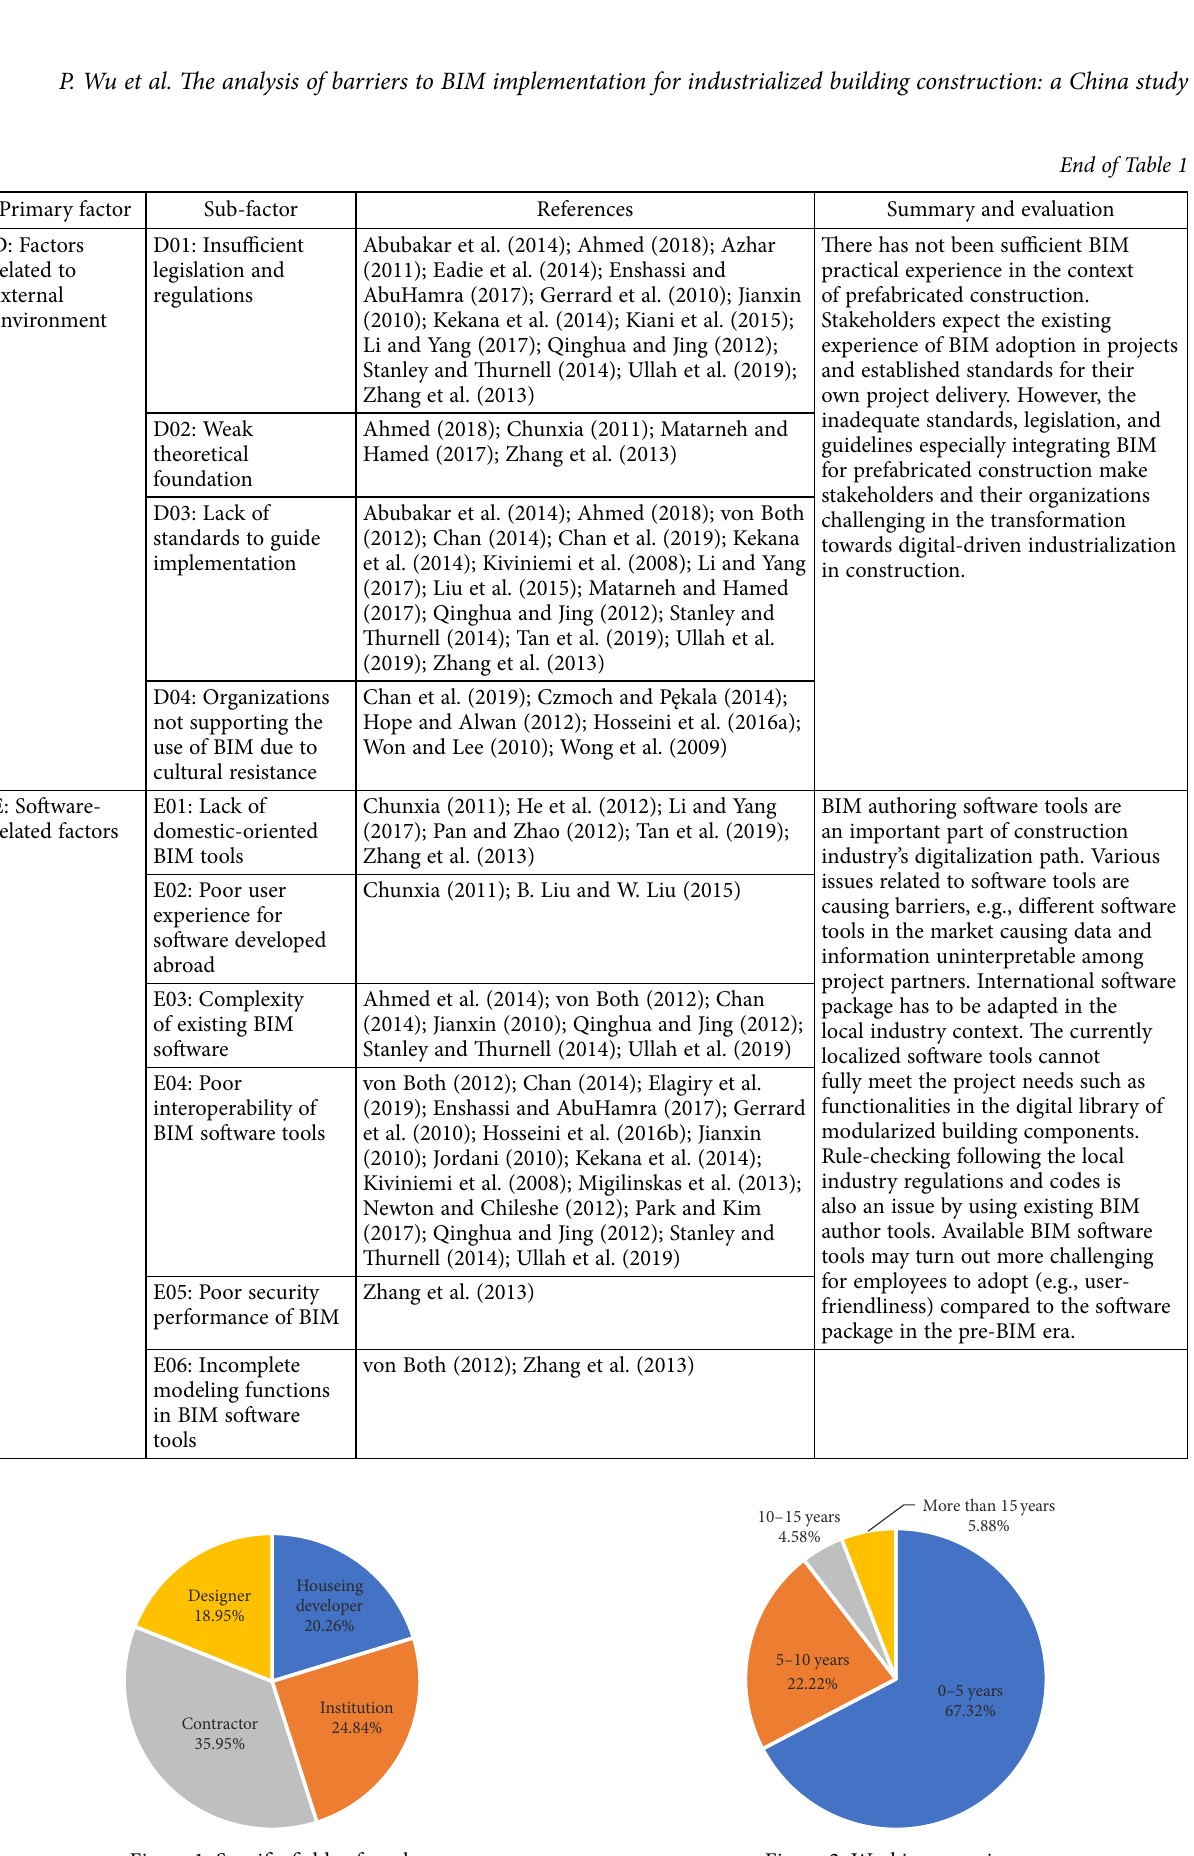
Figure 1. Specific fields of work Figure 2. Working